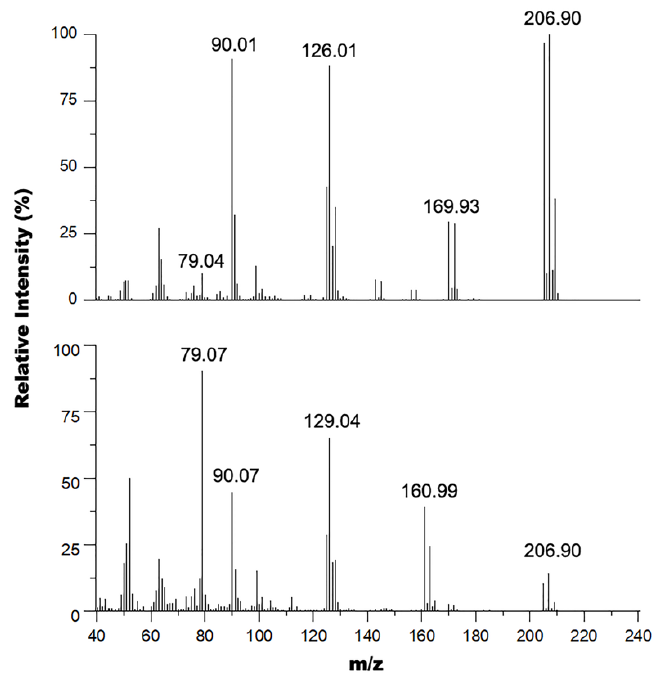
Figure 6. Overlay of the mass spectra of the product mixture from the reaction of 2-bromo-6-hydroxymethylpyridine with cyanuric chloride•DMF in DCM at r.t (top) and SOCl 2 at 40 °C (bottom).